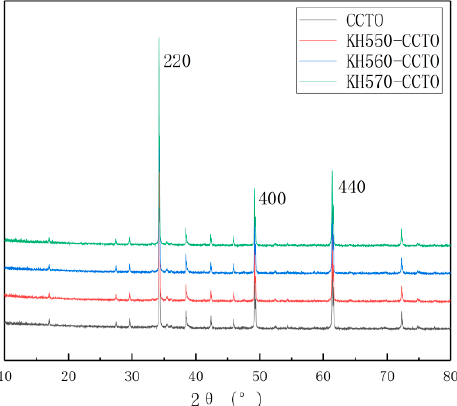
Figure 5. XRD spectrum of unmodified and modified CCTO